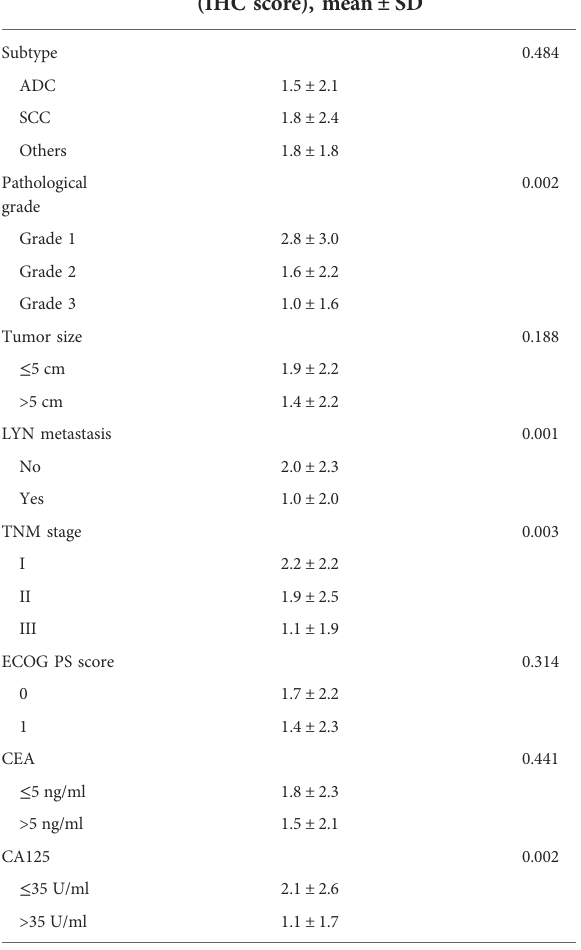
TABLE 3 Correlation of tumor PLK5 protein expression with disease